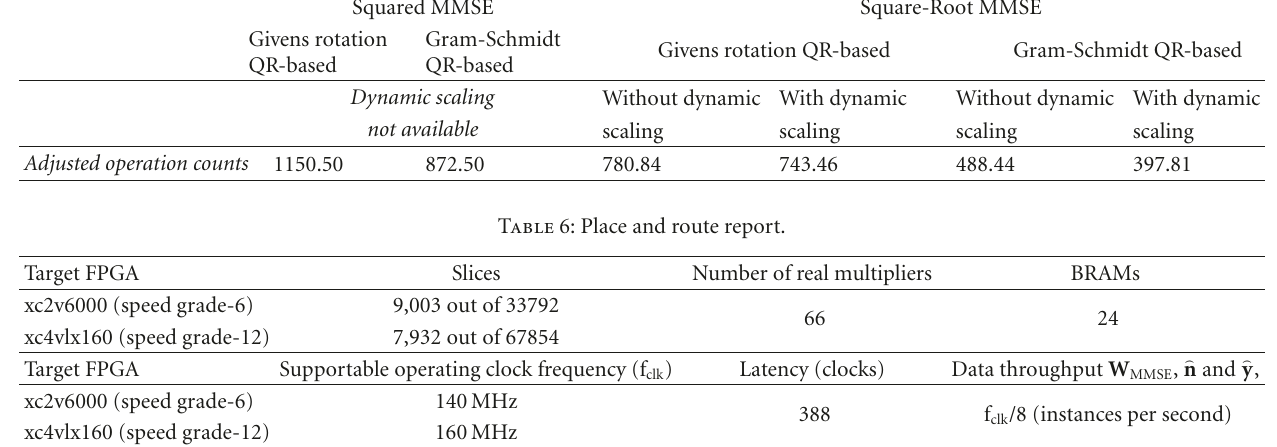
Table 5: Adjusted operation counts for computing W MMSE and